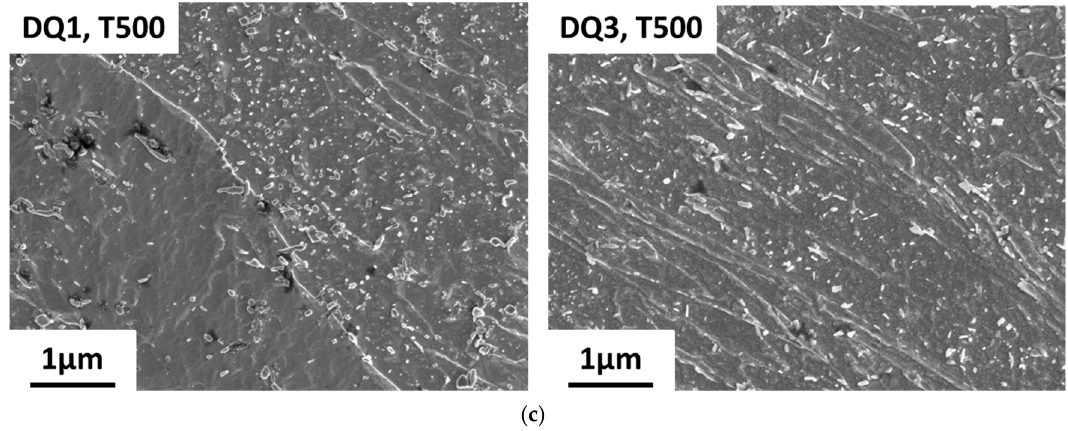
Figure 5. ( a ) Typical SEM micrograph of DQ3 steel (PAG = prior austenite grain), tempered at 550 °C (RD-ND section), ( b ) High magnification SEM micrograph showing temper carbides and residual martensitic lath structure of DQ3 steel, tempered at 550 °C, ( c ) Difference in remaining martensitic lath structure between DQ1 and DQ3 steel after tempering at 500 °C.